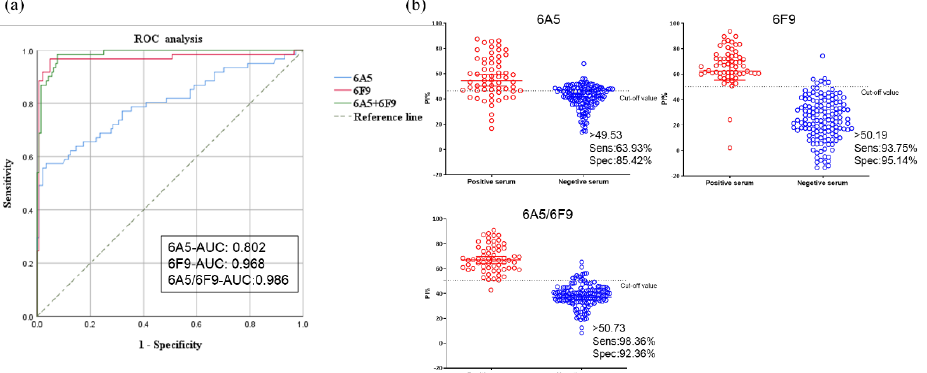
Figure 7. Serum sample analysis by 6A5, 6F9 and 6A5/6F9 − based blocking ELISAs. 61 ASFV − posi- tive serum samples and 144 ASFV − negative serum samples were analyzed by the three blocking ELISAs. ( a ). ROC analysis of the three blocking ELISAs. The AUC was 0.802, 0.968 and 0.986 for 6A5, 6F9 and 6A5/6F9 − based blocking ELISAs, respectively. ( b ). PI values of each pig serum sample, labelled with indicated cut − off values, sensitivity and specificity.